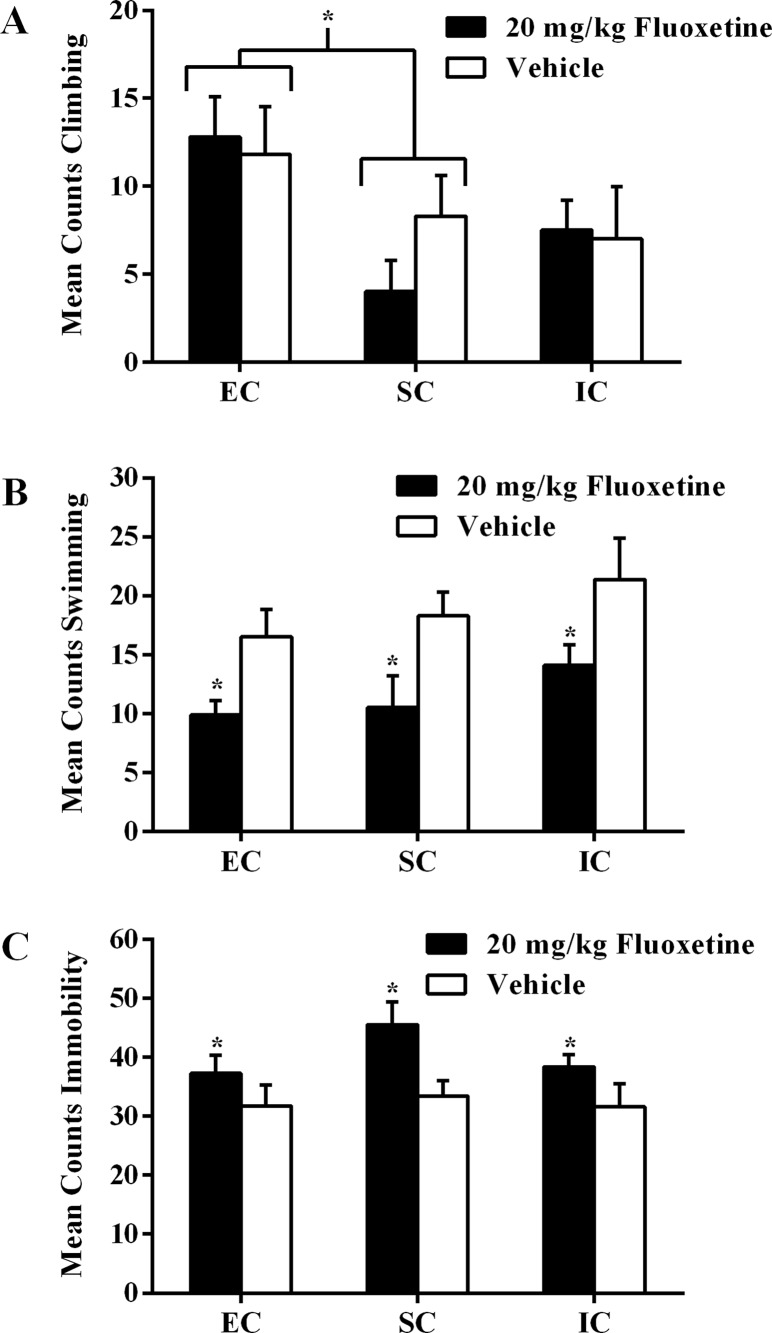
Experiment III Forced Swim Test Climbing, Swimming, and Immobility.Experiment III total mean counts (±SEM) of (A) climbing, (B) swimming, and (C) immobility behavior between EC, SC, and IC rats after subchronic fluoxetine (20 mg/kg, i.p.) or vehicle administrations before the FST. (A) Asterisk (*) indicates that EC rats exhibited more climbing behavior than SC rats, irrespective of drug treatment. (B) Asterisks (*) indicate that fluoxetine rats exhibited less swimming behavior than vehicle control rats. (C) Asterisks (*) indicate that fluoxetine rats exhibited significantly more immobility than rats administered vehicle control injections (p < .05).